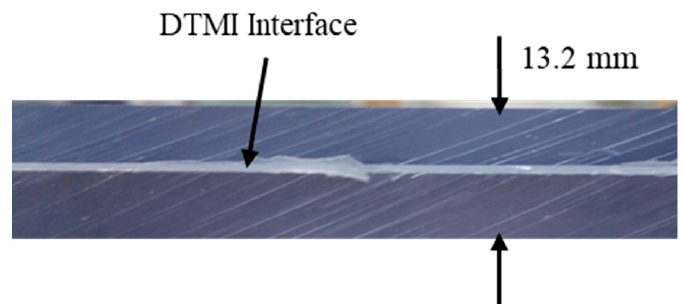
Figure 3. Side view of the bonded specimen showing DTMI interface.